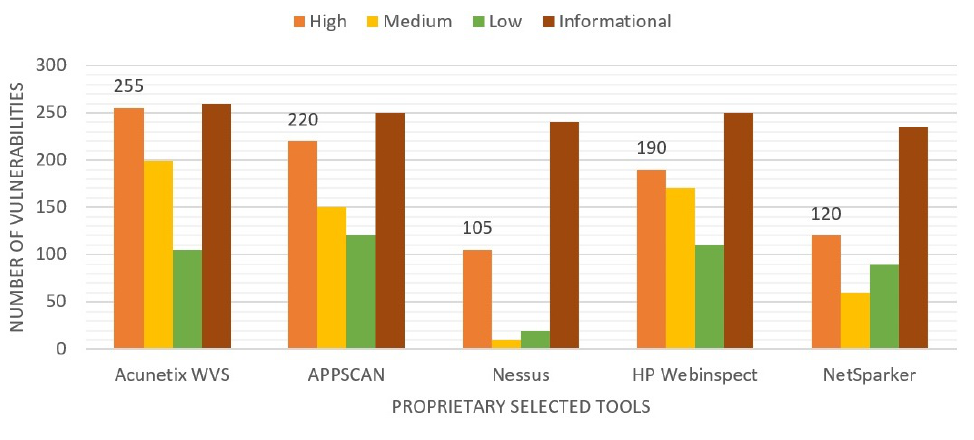
Figure 1. Detected Vulnerabilities on Proprietary Scanners.